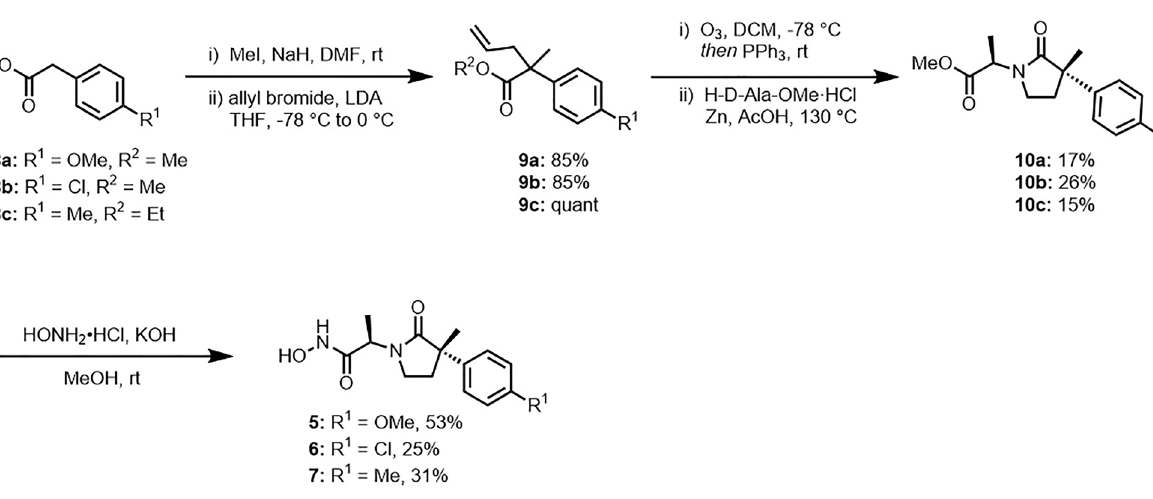
Figure 2. Analogue series alignment of KIF11 and MMP-1 inhibitors and SAR transfer from KIF11 to MMP-1.